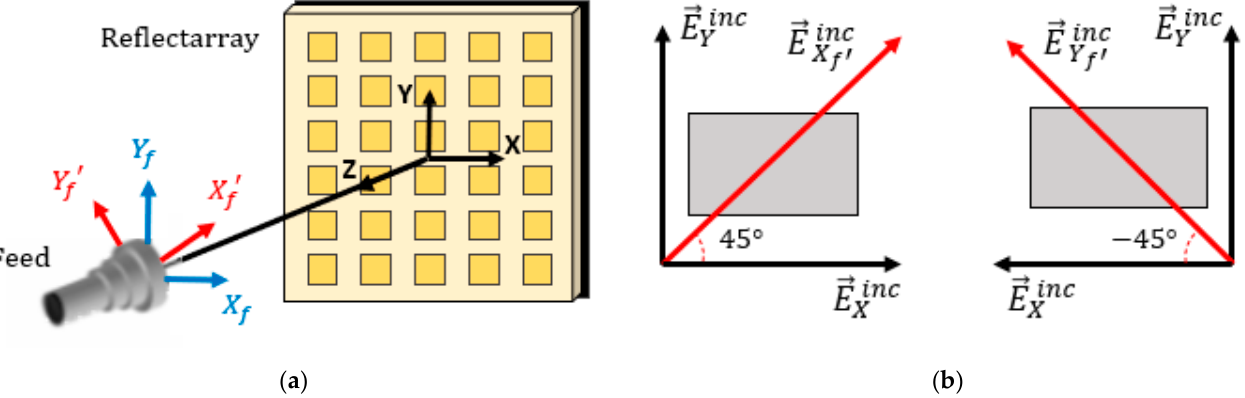
Figure 1. ( a ) Reflectarray antenna and illuminating horn, showing the orientation of the dual-LP radiated by the feed in order to generate a dual-LP beam ( X f and Y f axes, in blue) or a dual-CP beam ( X’ f and Y’ f axes, in red, obtained after rotating 45°). ( b ) Decomposition of the incident LP at ±45° slant into two orthogonal components in the direction of the x and y axes of the reflectarray. For simplicity, the reflectarray elements are represented as rectangular patches.